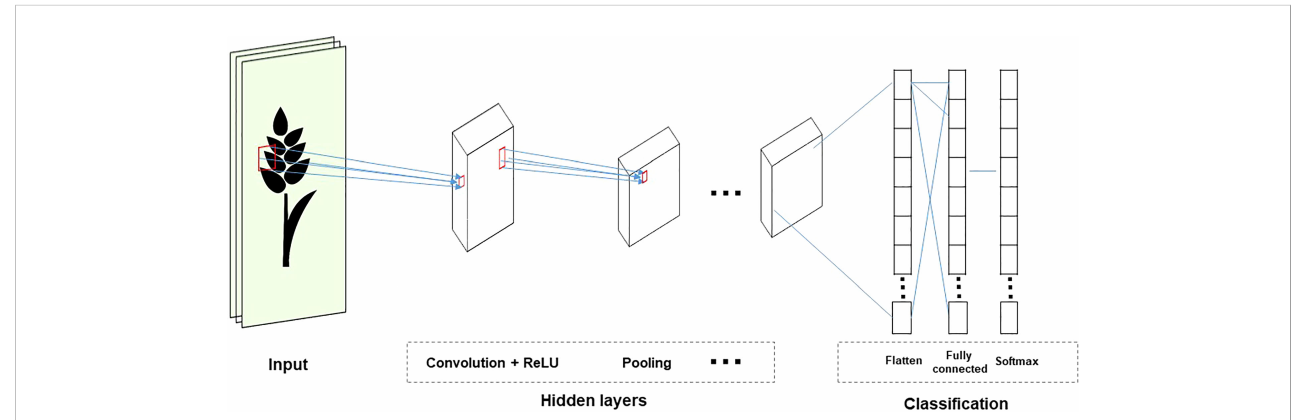
FIGURE 5 The structure of the CNN